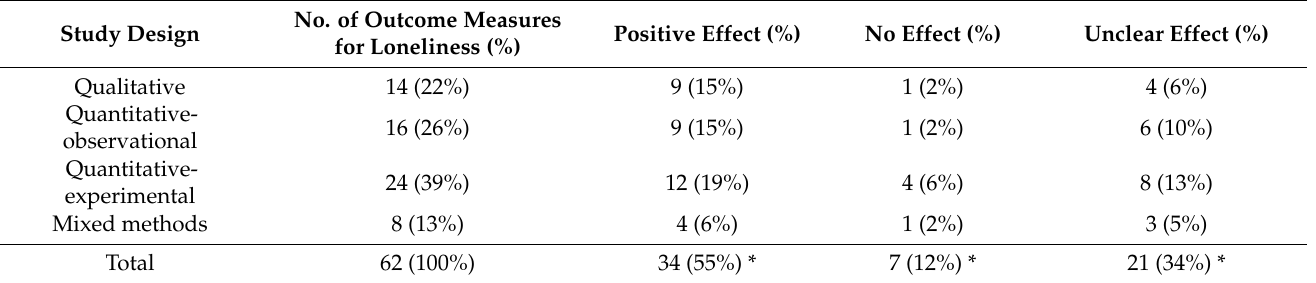
Table 5. Effects of CT Use on Loneliness Among Older Adults as Reported by Included Reviews Grouped According to Study Design.